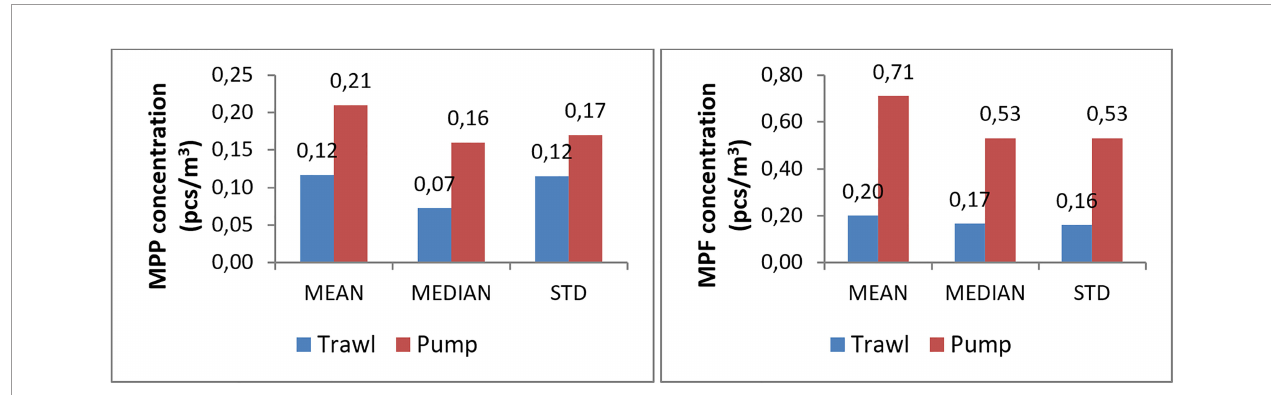
FIGURE 6 | Mean, median and standard deviation (SD) of the multiple microplastic datasets. Left panel: MPP, right panel: MPF. Blue: trawl small-mean population, red: pump small-mean